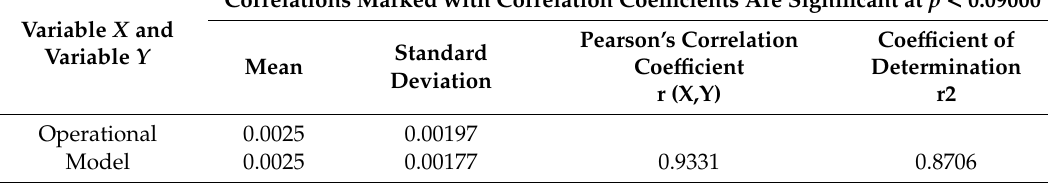
Table 5. Results of correlation analysis for the group of tested steels in medium soil. Variable X and Variable